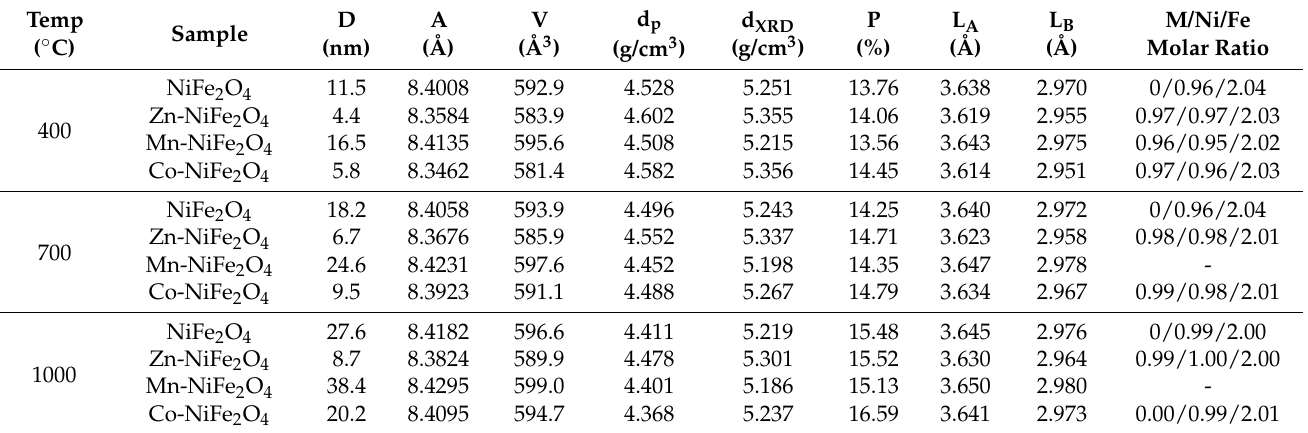
Table 1. Crystallite size (D), lattice constant (a), unit cell volume (V), bulk density (d p ), X-ray density (d XRD ), porosity (P), hopping length in tetrahedral sites (L A ) and in octahedral sites (L B ) and